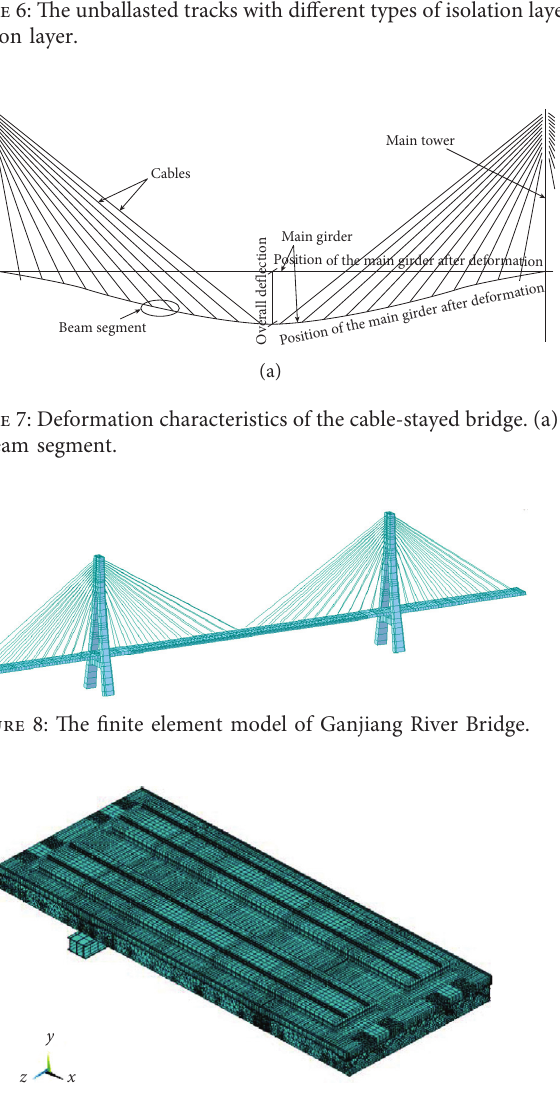
Figure 9: The finite element model of the segment model.